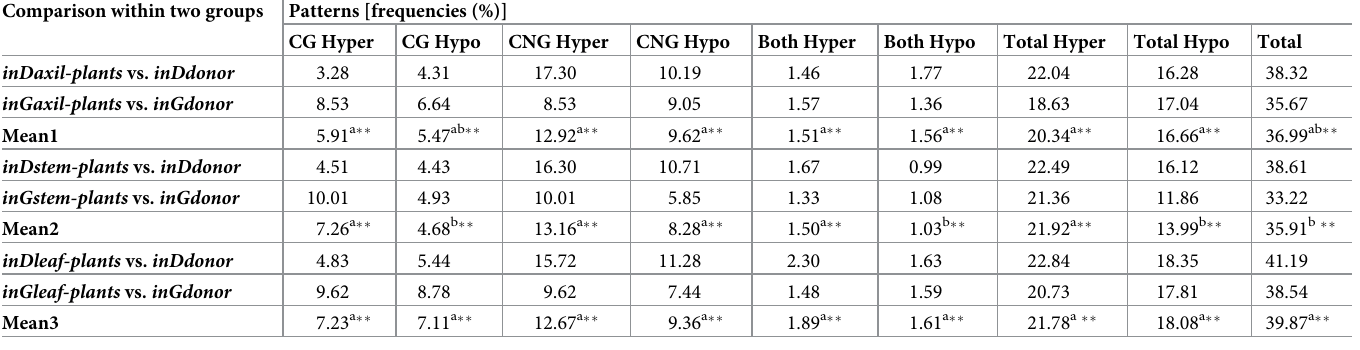
levels (Table 4). Broad DNA methylation changes occurred during in vitro cultures of L . ruthe- nicum and there were some differences among the three types of plants. The average levels of CG hypomethylation (CG Hypo), CG & CNG hypomethylation (Both Hypo) and total methyl- ation changes (Total Hyper + Total Hypo) in plants from stem calli were all the lowest and the counterparts in plants from leaf-calli, however, were all the highest (Table 4). To sum up, in vitro L . ruthenicum plants arranged in increasing order according to levels of total locus-spe- cific methylation alterations relative to the in vitro donors are as follows: plants from stem calli, plants from axillary buds and plants from leaf calli. Moreover, for each types of the micro- propagated plants in vitro , CG Hyper > CG Hypo; CNG Hyper > CNG Hypo; Total Hyper > Total Hypo (Table 4). All the patterns of locus-specific methylation alterations in three types of micropropagated plants ex vitro versus the ex vitro donor plants were statistically significant with Both Hypo and Both Hyper of plants from axillary buds at 0.05 levels and the others at 0.01 levels (Table 5). After transplanting, the level of CG Hyper in plants from stem calli was significantly higher than that in plants from axillary buds. However, the level of CG Hypo was contrary to that of CG Hyper (Table 5). Unlike in vitro plants, the total level of locus-specific methylation alterations in the ex vitro plants from stem calli was the highest but there was no statistical sig- nificance. Just like that in vitro , for each type of the micropropagated plants ex vitro , the level of hypermethylation was higher than that of hypomethylation (CG Hyper > CG Hypo, CNG Hyper < CNG Hypo, Both Hyper > Both Hypo, Total Hyper > Total Hypo). From the data of Tables 4 and 5 we concluded that internal cytosine MSV of CCGG sites (CG Hyper and CG Hypo) in three types of micropropagated plants increased and that of CNG (external cytosine) decreased after acclimatization (Table 6). Also, the levels of CG Hyper in plants from calli of both leaf and stem were significantly increased (P < 0.01) after acclimatization (Table 6). However, after acclimatization the levels of CNG Hyper in all the three types of micropropagated plants were significantly decreased (P < 0.01) (Table 6). There were one and two patterns of significant methylation alterations in plants from axillary buds and calli, respectively (Table 6), suggesting that the MSV of plants from two types of calli showed the sharpest changes in response to acclimatization and the smallest changes were in